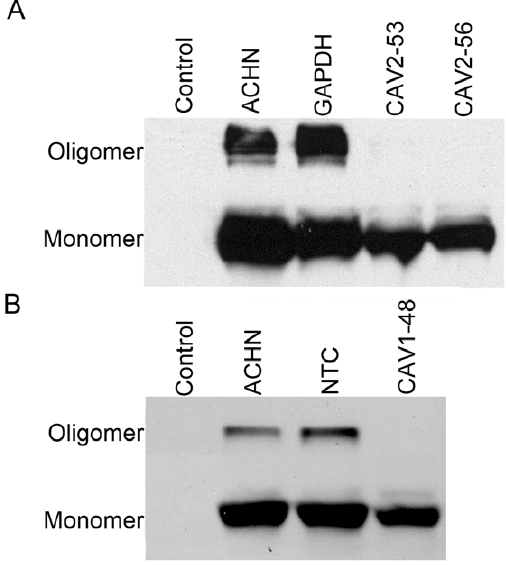
Figure 6. Specific co-immunoprecipitation of e -toxin and caveolins. A) ACHN cells were either untreated (control) or treated with GFP-labeled toxin. Cell lysates were incubated with beads crosslinked to CAV2, E-cadherin or transferrin receptor antibodies. Proteins eluted off the beads were analyzed by immunoblotting with anti-GFP antibody. B) ACHN cells were either untreated (control) or treated with GFP-labeled toxin. Cell lysates were incubated with beads crosslinked to CAV1 antibodies. Proteins eluted off the beads were analyzed by immunoblotting with anti-GFP antibody. Representative immunoblots are shown.